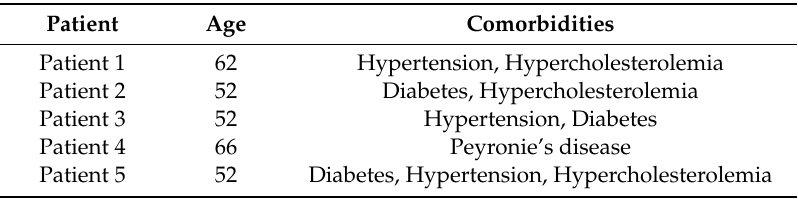
Table 1. Patients’